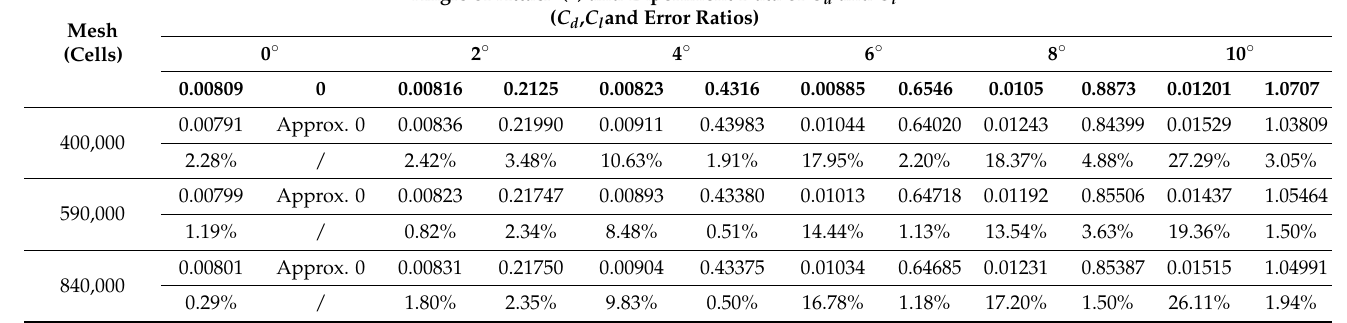
Table 2. Grid independency study of three levels of different mesh with error ratios at a far-field distance of 16